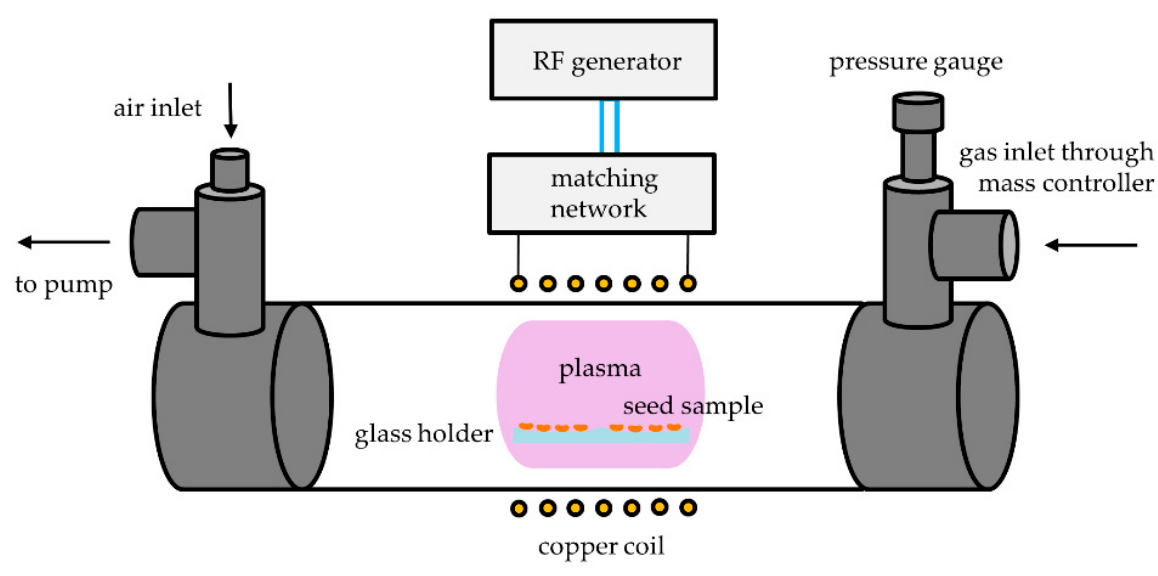
Figure 1. Schematic representation of the plasma system used for the treatment of bean seeds. Adapted from Recek et al. [23].